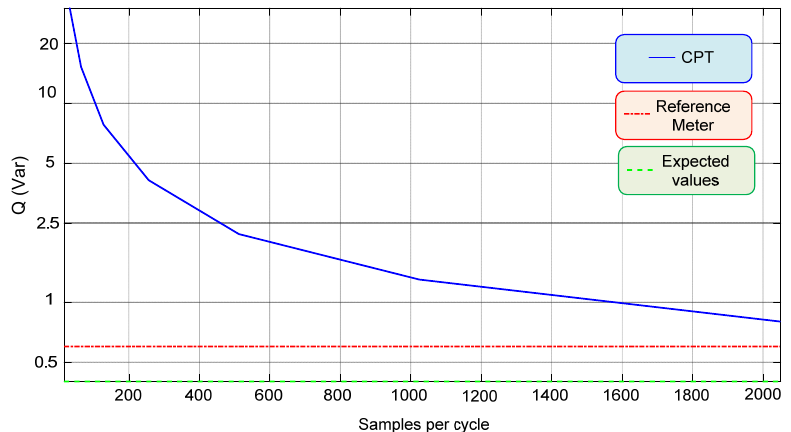
Figure 4. Reactive power for three resistive loads in parallel.